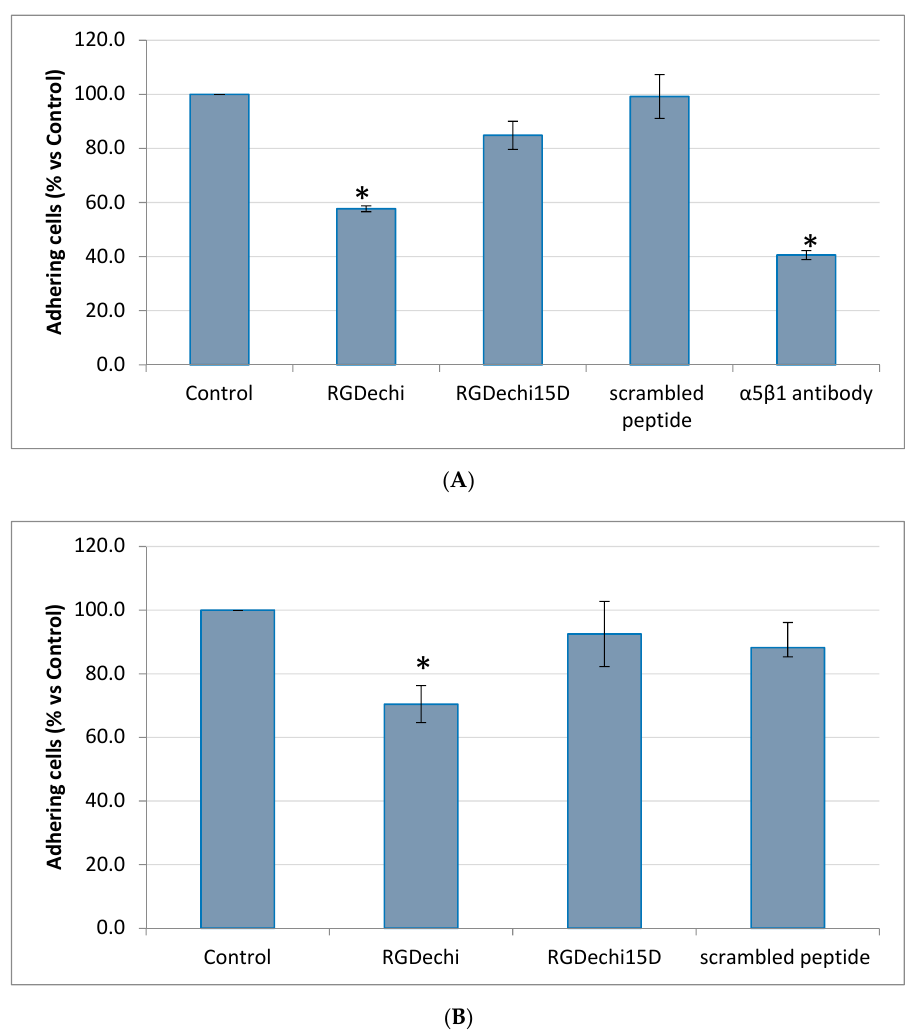
Figure 3. ( A ) Effect on K562 cell adhesion on fibronectin coated plates. Cells were pre-incubated with 50 µM RGDechi15D or RGDechi (used as positive control) or 10 µg/mL anti- α v β 5 antibody, for 30 min at 4 °C and then seeded on fibronectin coated plates at 37 °C. Cell adhesion was evaluated after 1 h of incubation using crystal violet reagent. ( B ) Effect on K562 adhesion on α 5 β 1 antibody coated plates. K562 were pre-incubated with peptides (50 µM) for 30 min at 4 °C then seeded on anti- α 5 β 1 coated plates. The results are presented as the percentage of adherent cells respect to the control (untreated cells) and are expressed as means ± SE of at least three independent experiments performed in triplicate. Statistical significance was analyzed using Student’s t test, unpaired, two-sided (* p < 0.05).